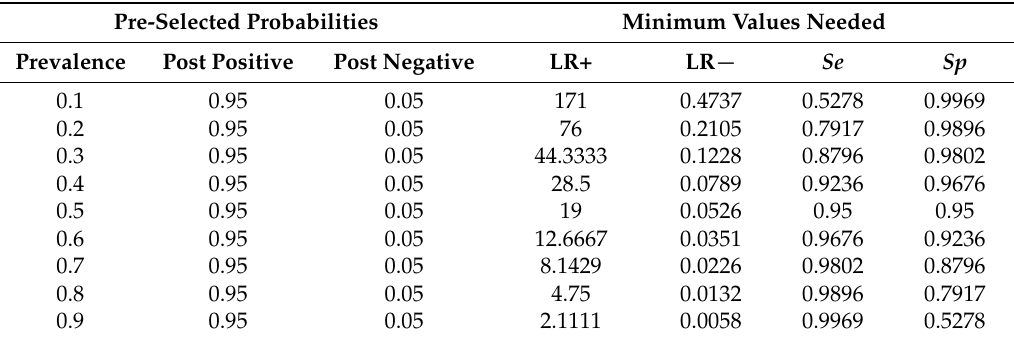
Table 3. The influence of prevalence on the desired levels of Se and Sp when the post-test probabilities are kept